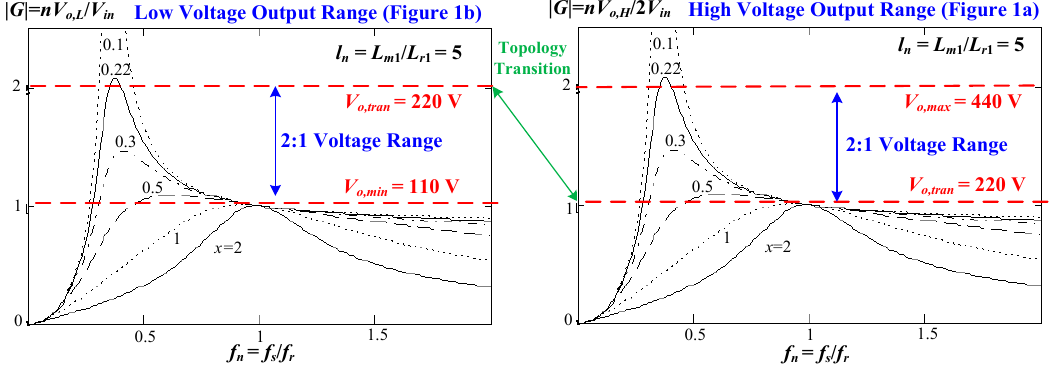
Figure 4. Gain curves of the studied circuit with output voltage V o = 110 V~440 V and input voltage V in = 380 V.